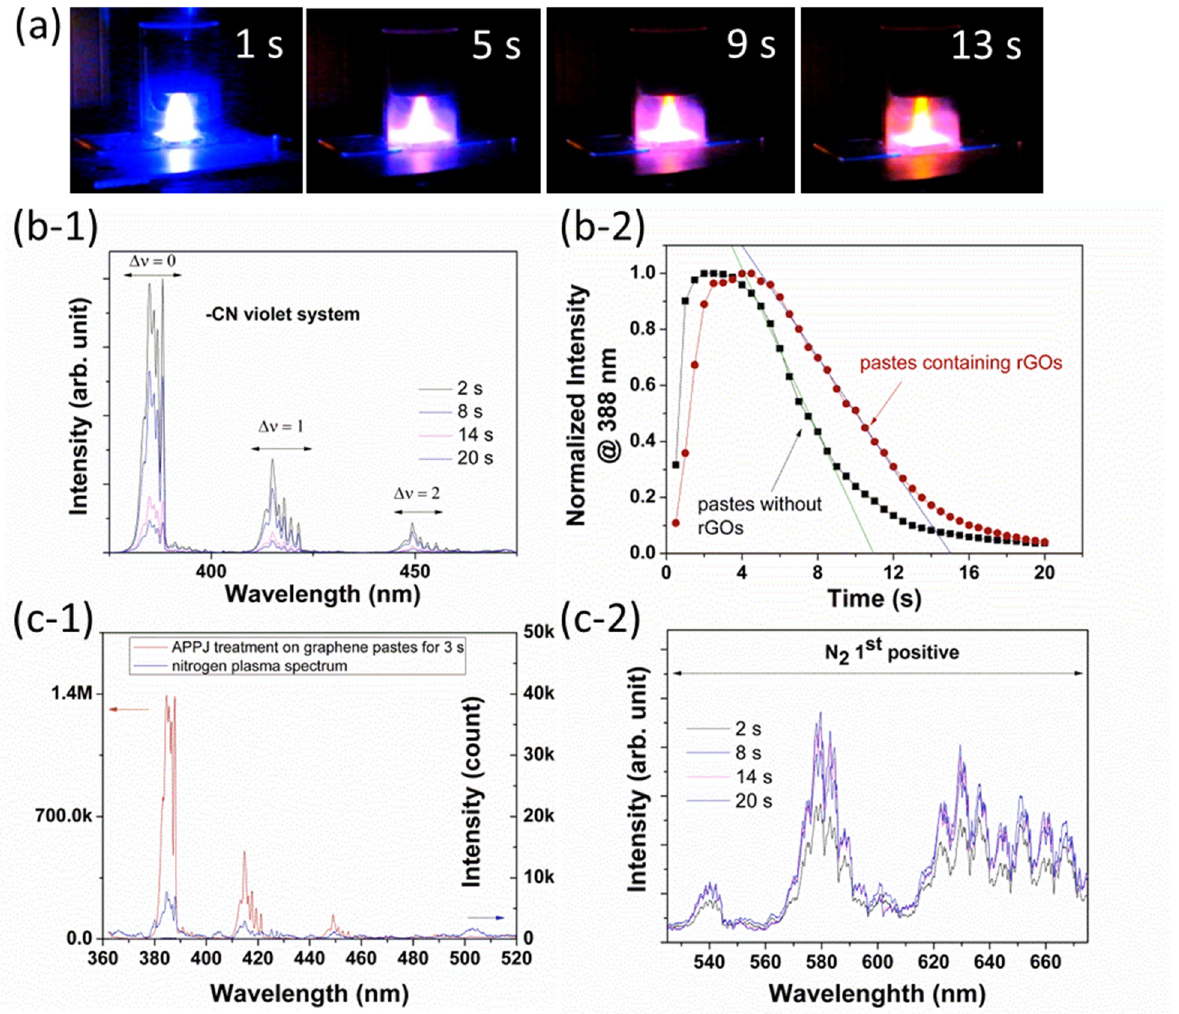
Figure 3. APPJ sintering on reduced graphene oxide (rGO) pastes. ( a ) Snap shots of APPJs during operation; ( b-1 ) OES spectra of CN violet system, ( b-2 ) evolutions of normalized intensities of 388 nm emission for APPJ sintering on pastes with and without rGOs; ( c-1 ) OES spectra taken for bare N 2 -APPJ (no rGO pastes) and taken during N 2 -APPJ sintering on rGO pastes after 3 s, and ( c-2 ) OES spectra of N 2 1st positive emissions taken during N 2 -APPJ sintering on rGO